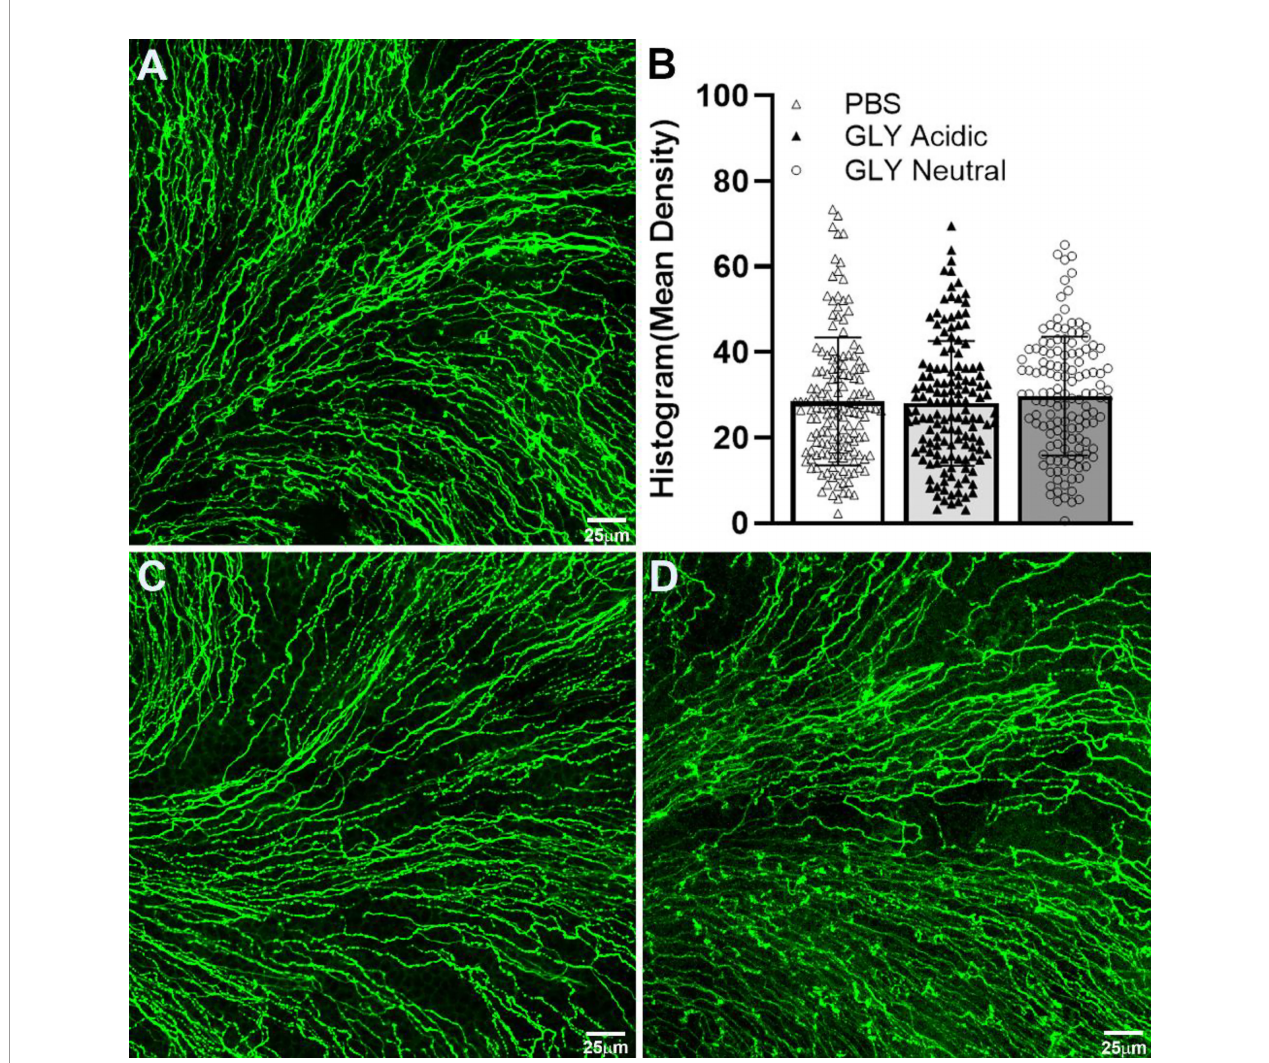
FIGURE 2 | Confocal images of corneal whole mounts stained with b -tubulin to visualize corneal nerves. Mice received topical PBS (A) , acidic (C) , or neutral (D) GLY onto the normal, unwounded cornea for 4 days and were tested on day 5. (B) Histogram analysis showed no differences in nerve fi ber density among the three groups. Data are expressed as mean ± SEM (n = 3/group). Scale bar = 25 m